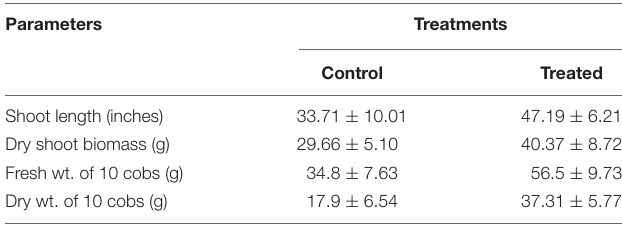
TABLE 2 | Effect of D. cinnamea 55 inoculation on growth of corn (Microplot trial). Parameters